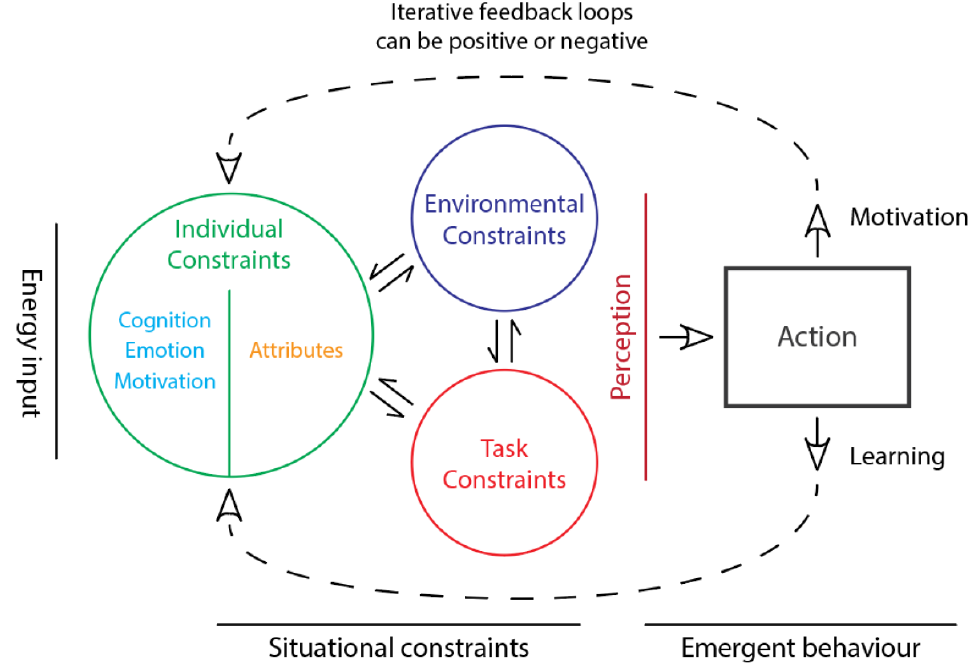
Figure 3. Dynamics model for decision-making and learning, adapted with permission from Davies, M.J. and Davies, R.S. [9]. Motivation is the initial start point, defining the quality of individual input into learning and decision-making tasks. Decision-making behaviours are shaped by intentions and perception of available affordances, within situational constraints. These constraints are broadly categorised into individual, environment, and task. Differences in individual perception, motivation and meaning shape the influence of constraints and account for diversity of decisions. Within mineral exploration, these decisions can include activities such as collecting additional geoscientific data (e.g., airborne geophysical surveys, surficial geochemical sampling), direct drill-testing of targets, or even choosing to relinquish ground. The results of hypothesis-testing actions are observed, changes in perception and decision-making may be implicit or explicit making them more difficult to identify, the influence of constraints may be redefined, and hypotheses subsequently adapted. This process of active learning results in perception-action coupling, where feedback or results have an impact on individual learning and motivation, through a learning feedback loop, defining an autopoietic (i.e., self-organising and self-regulating)